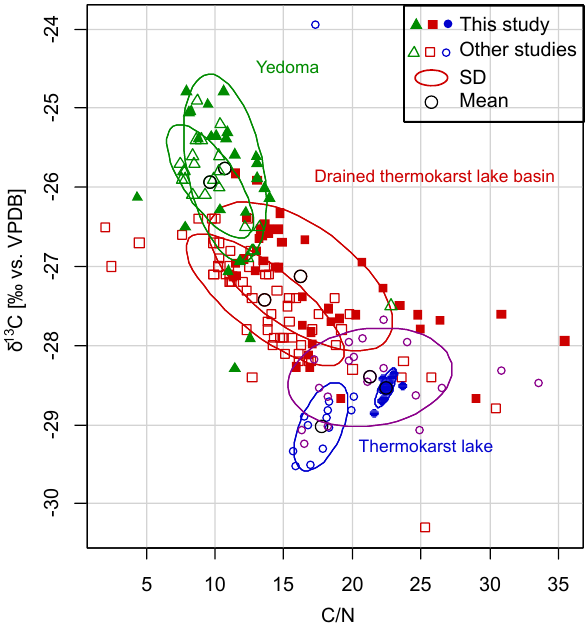
Figure 5. Scatter plot of total organic carbon to total nitrogen (C / N) ratio and stable carbon isotopes ( δ 13 C) of yedoma deposits (green triangles), drained thermokarst lake basin (DTLB) deposits (red squares) and thermokarst lake sediments (blue and purple dots) in Alaska. Mean values and standard deviations (SD) indicated. Data from this study (filled symbols): Baldwin Peninsula; data from other studies (hollow symbols): Itkillik River (Lapointe et al., 2017; Strauss et al., 2012), northern Seward Peninsula (Lenz et al., 2016a) and lakes from Kobuk River Delta (blue) and central Seward Penin- sula (purple) (Lenz et al.,